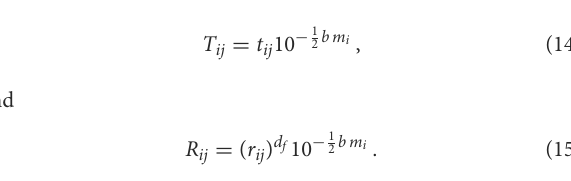
2.97; red symbols ≥ −